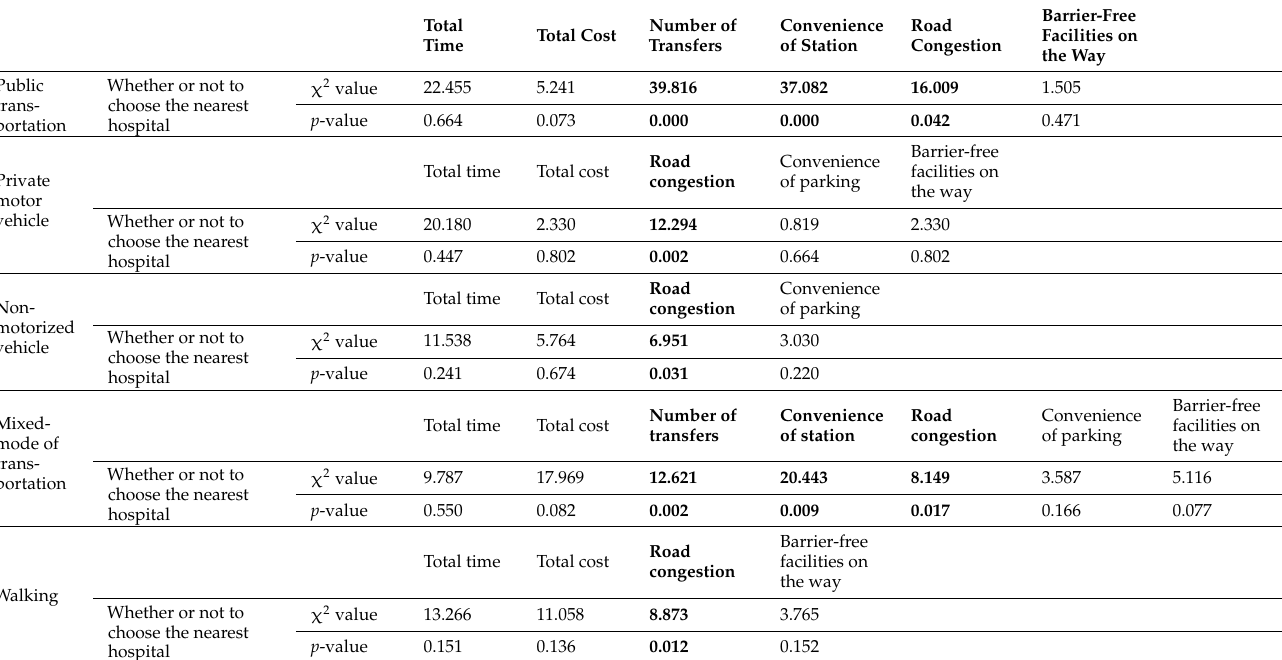
Table 6. Chi-squared analysis on the accessibility evaluation of the elderly and their behavior.